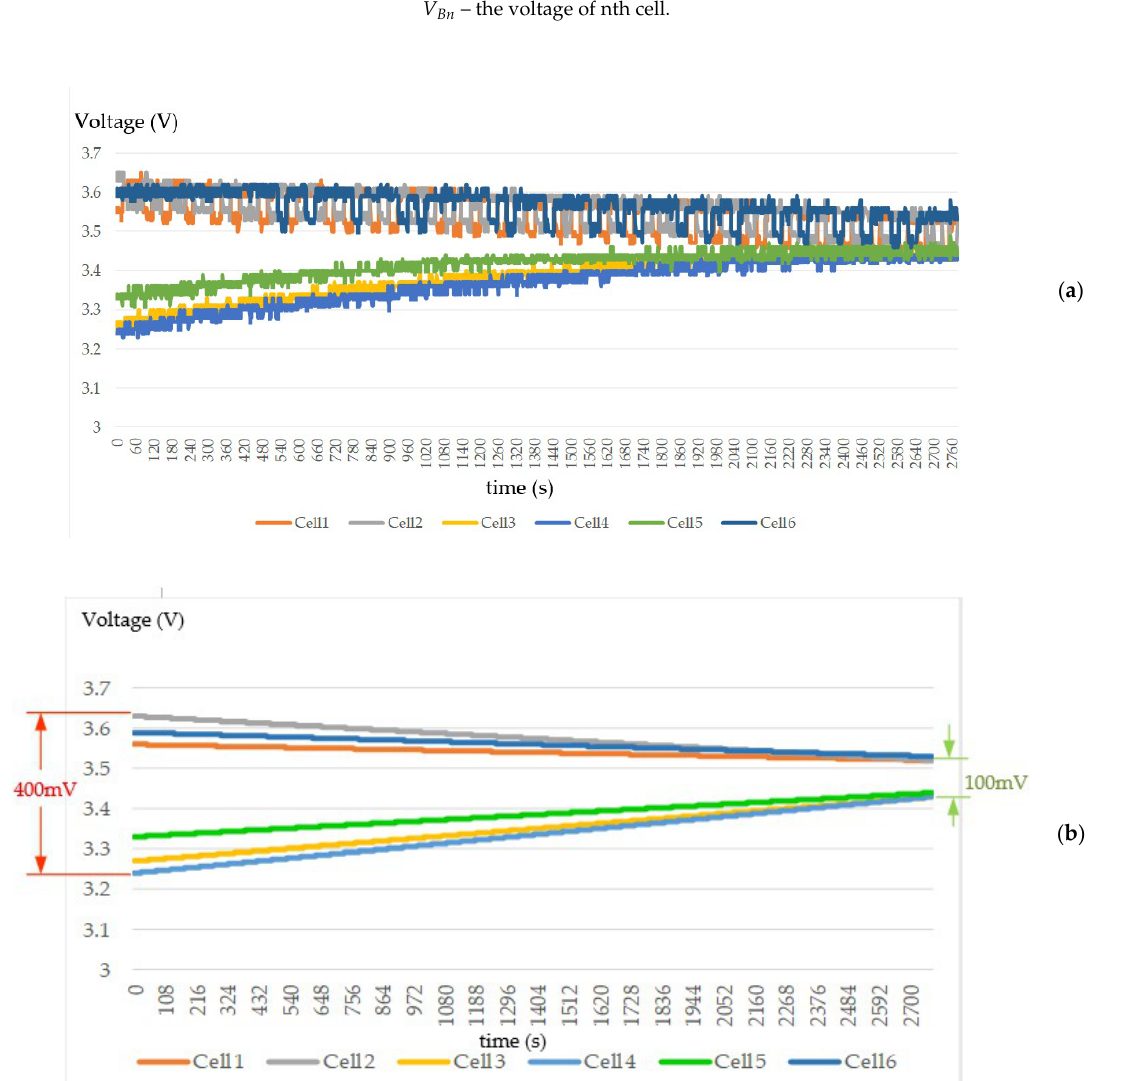
Figure 11. Measured voltage of each cell using cell-to-pack procedure ( a ) actual hardware measurements ( b ) processed results.